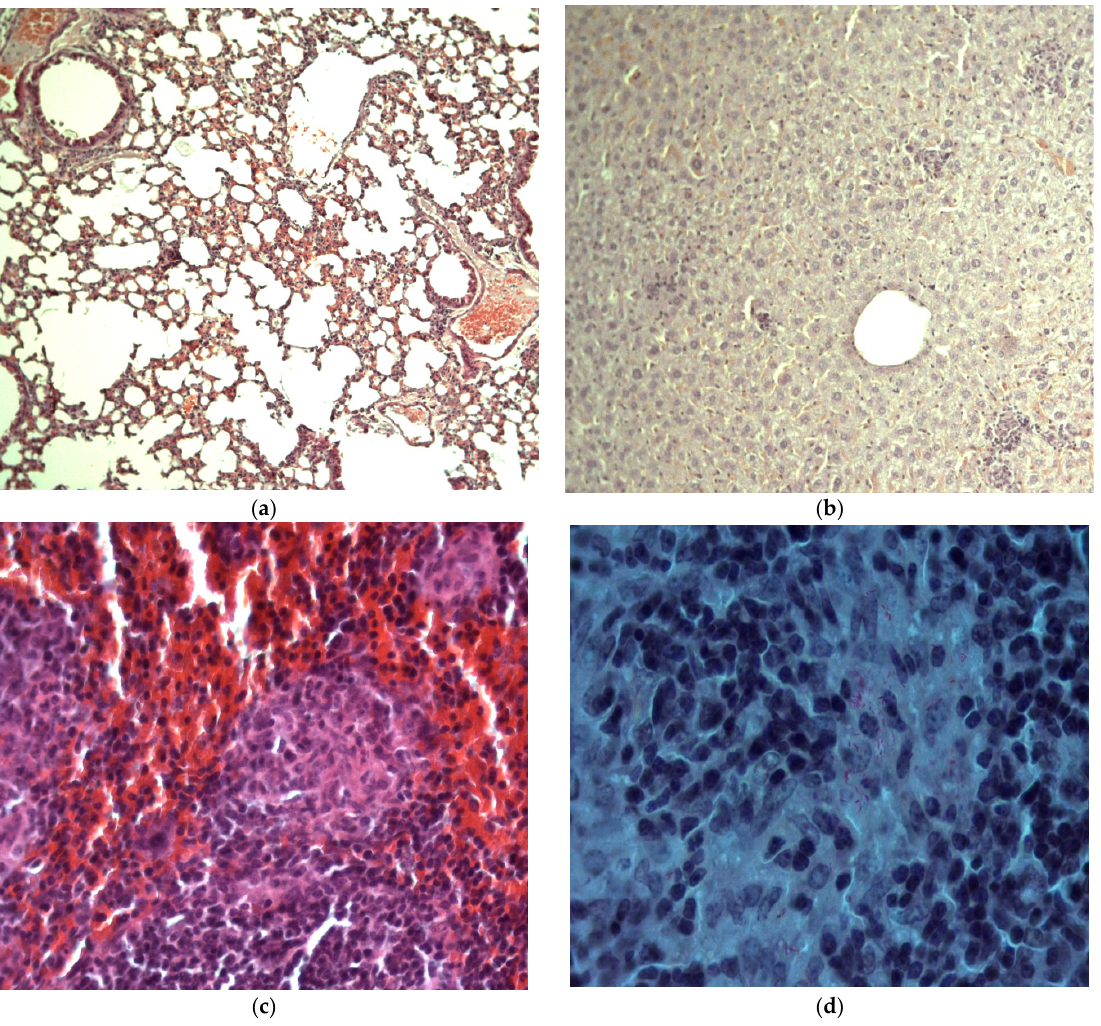
Figure 6. Histologic preparations of lungs ( a ), liver ( b ), and spleen ( c , d ) of the animals from the Control (+) group, coloration with hematoxylin-eosine, magnification 20×, MBT in granuloma— Ziehl-Neelsen coloration, magnification 40×.